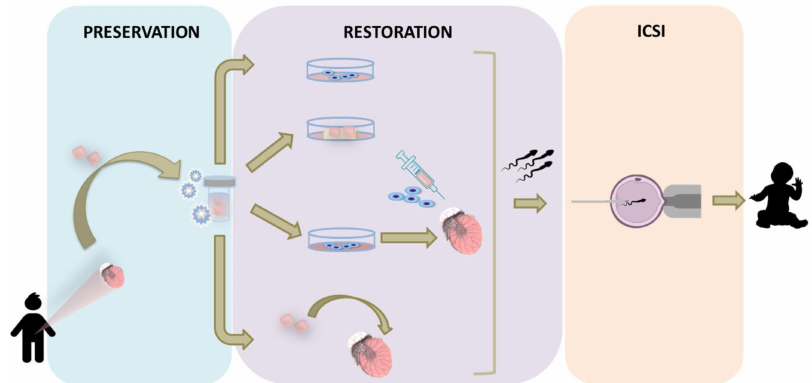
Figure 4. Overview of the experimental in vitro and in vivo strategies developed for boys based on the use of immature testicular tissue. Testicular tissue containing SSCs, obtained by biopsy before the initiation of the gonadotoxic treatment, can be cryopreserved and used later in life for fertility restoration. Di ff erentiation of SSCs cultured either as single cells obtained after testicular tissue digestion, or in organ culture, can lead to sperm generation (in vitro approaches). Alternatively, SSCs can be transplanted following propagation into the rete testis of the patient, or intact testicular tissue can be orthotopically transplanted back to the individual (in vivo approaches). Sperm retrieved by any of the proposed strategies can be used for intracytoplasmic sperm injection